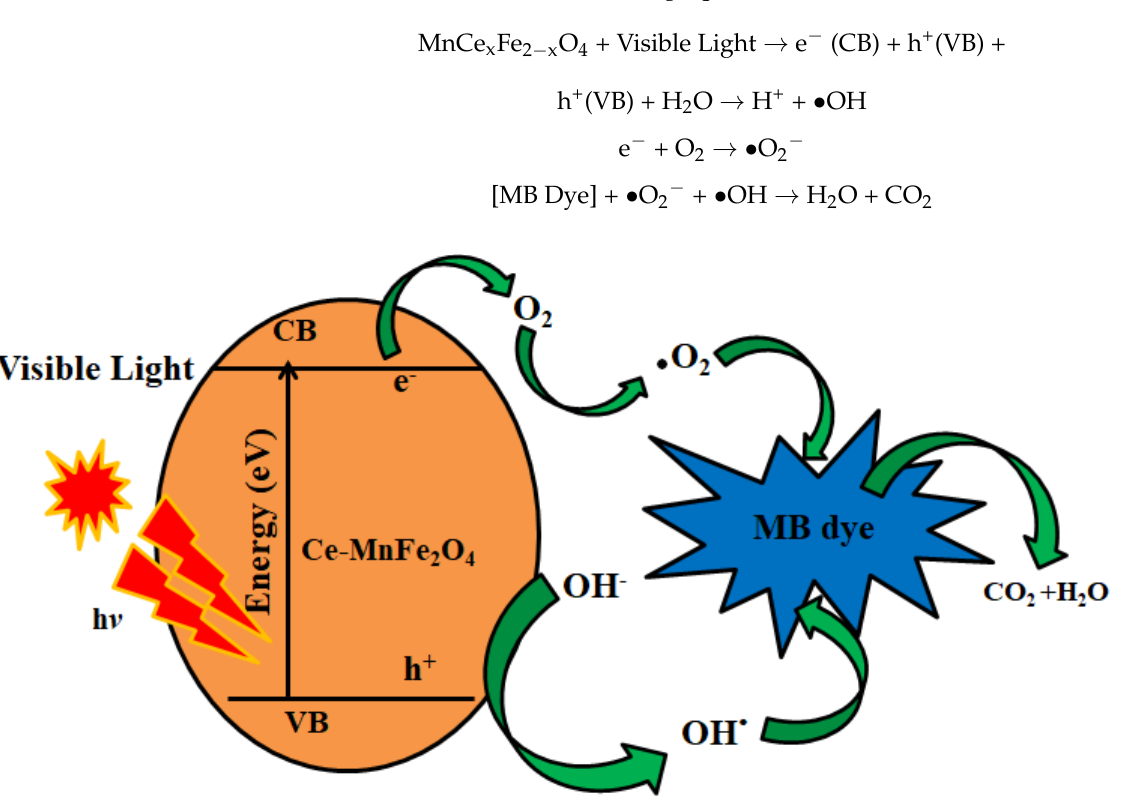
Figure 10. Photo-degradation (PCD) mechanism of MB dye using spinel Ce:MnFe 2 O 4 NCs.